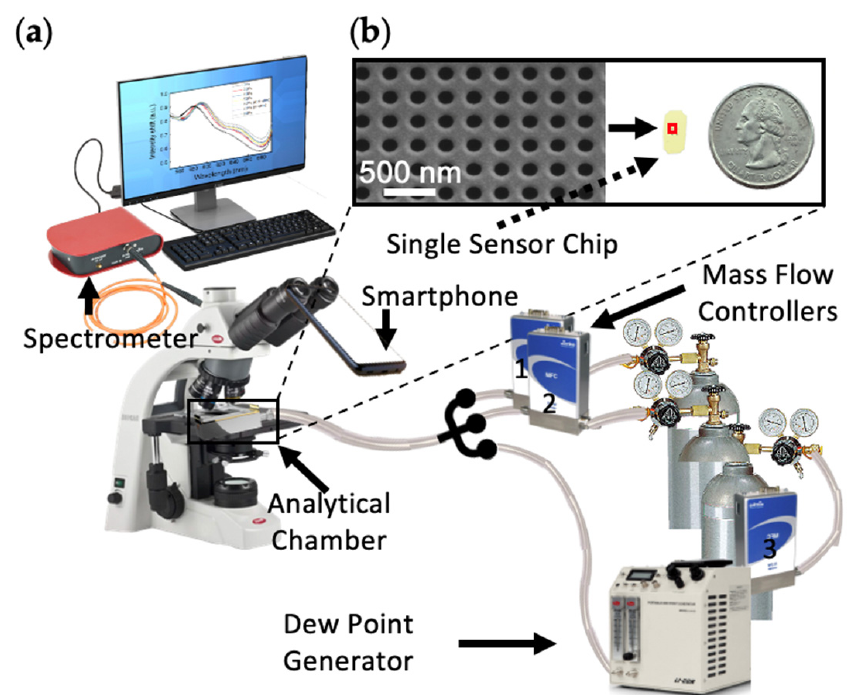
Figure 2. Sensing setup. ( a ) Diagram of the sensing system consisting of a spectrometer, a smartphone, microscope, NHA sensors, MFCs, and dew point generator. ( b ) SEM image of the bare NHA structure and an image of a single sensor chip versus a quarter. The chip had 4 NHA sectors, each with an area of 300 µm × 300 µm.